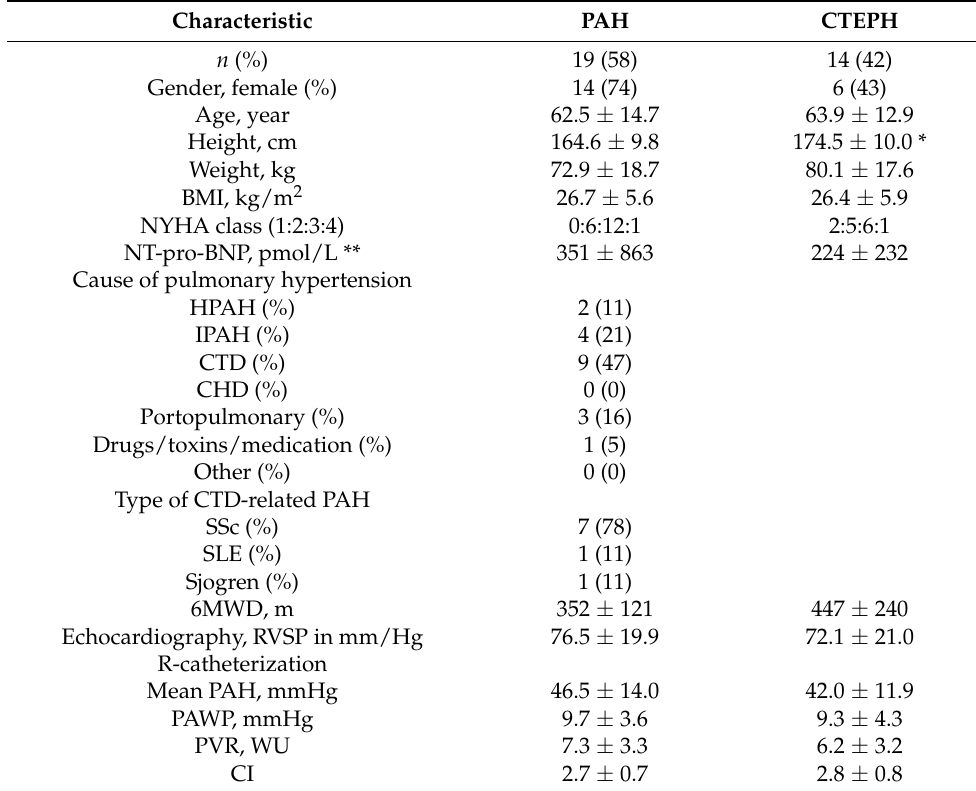
Table 1. Characteristics of patients in the newly diagnosed group.